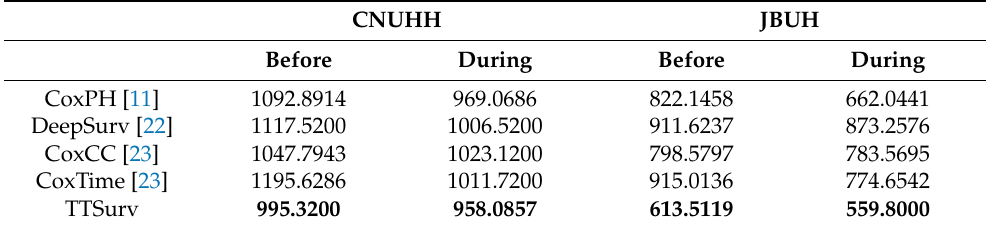
677 Figure 4. Representative estimated individual survival curves for fi ve patients with ground truth survival times in the range of 527–2421 days. As indicated in Figure 5, we compared features used both before and during treat- ment analysis for all uncensored patients in the test set. The estimated survival times were generally close to the ground-truth values. However, the survival times were poorly esti- mated for some cases, as mentioned in Table 4. In summary, we demonstrated that TTSurv could estimate the survival times with a relatively small MAE of approximately 559 days.